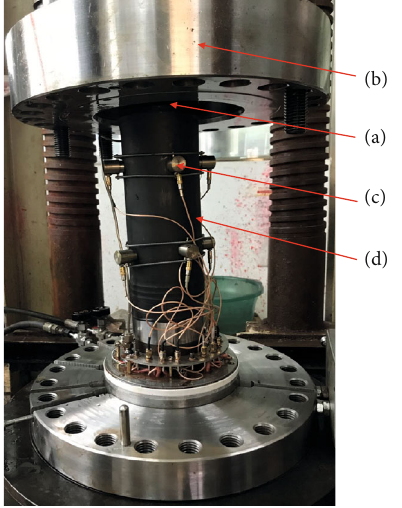
Figure 3: Triaxial testing system: (a) top cap for applying axial stress (not visible); (b) con fi ning chamber for applying con fi ning stress; (c) acoustic sensors attached to the sealing tubing; (d) sealing tubing (two layers of heat-shrink